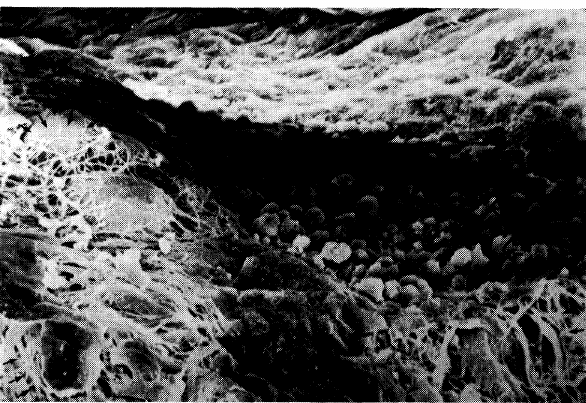
FIG. 3c. 3 min after ZAP exposure. The mesothelial cell layer has been destroyed. The cross network of submesothelial connective tissue and underlying fat cells are uncovered as